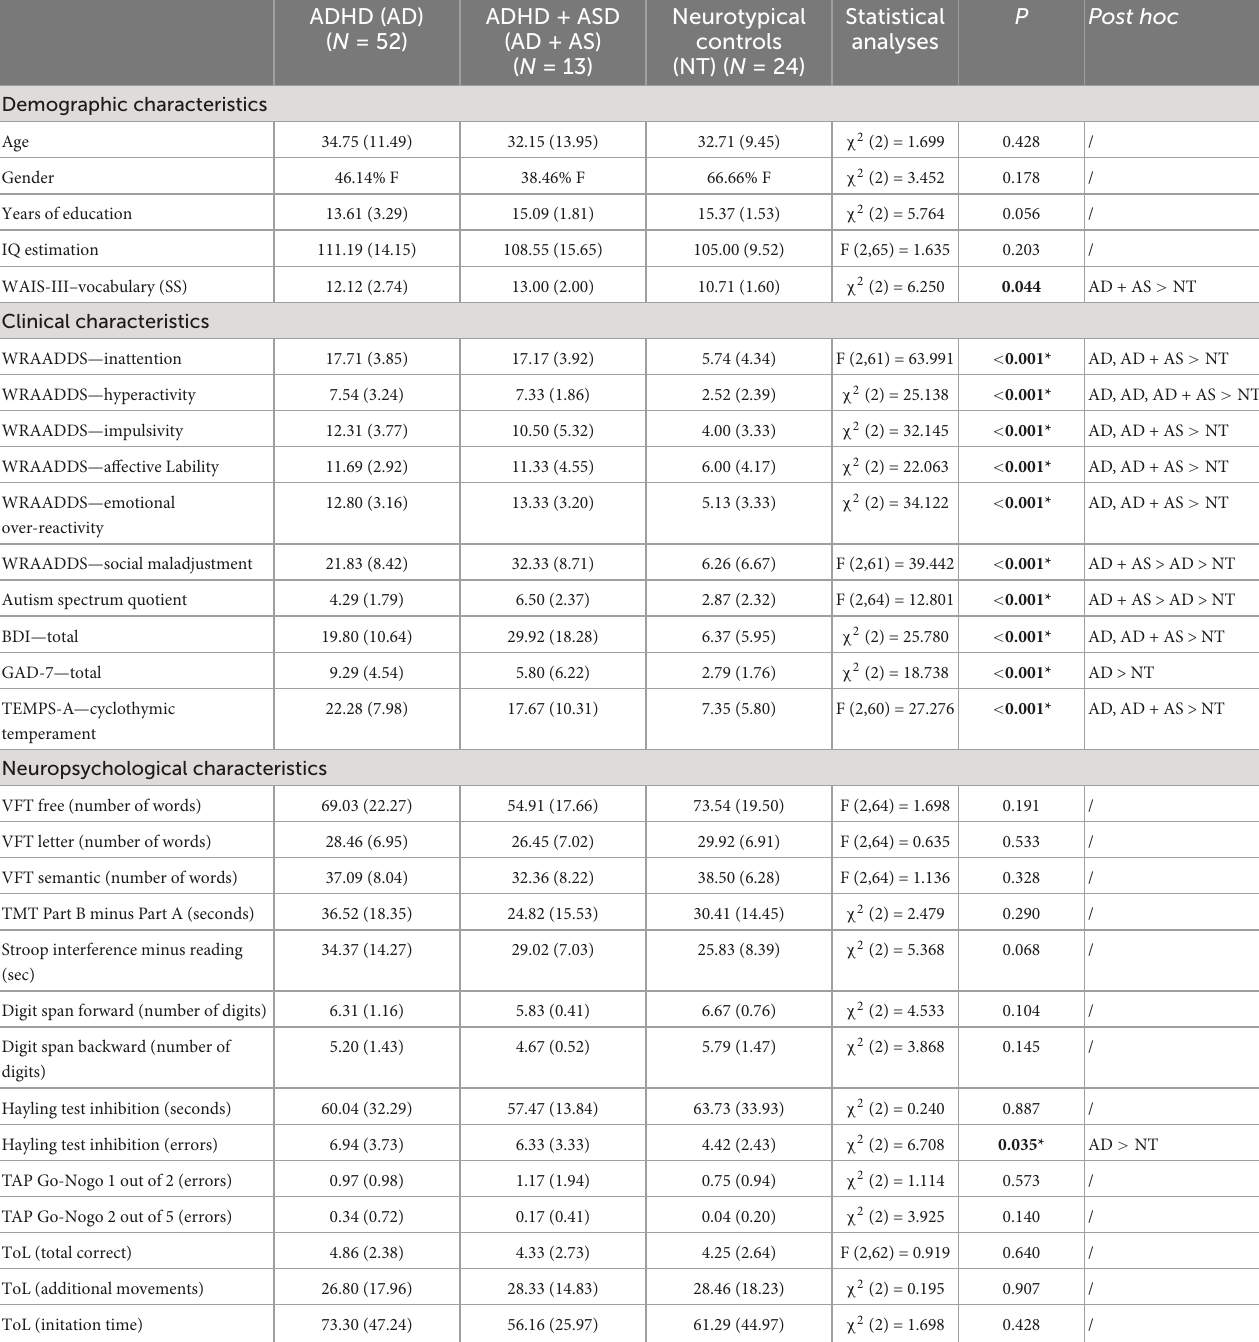
TABLE 1 Demographic, clinical and neuropsychological characteristics of participants in each group.